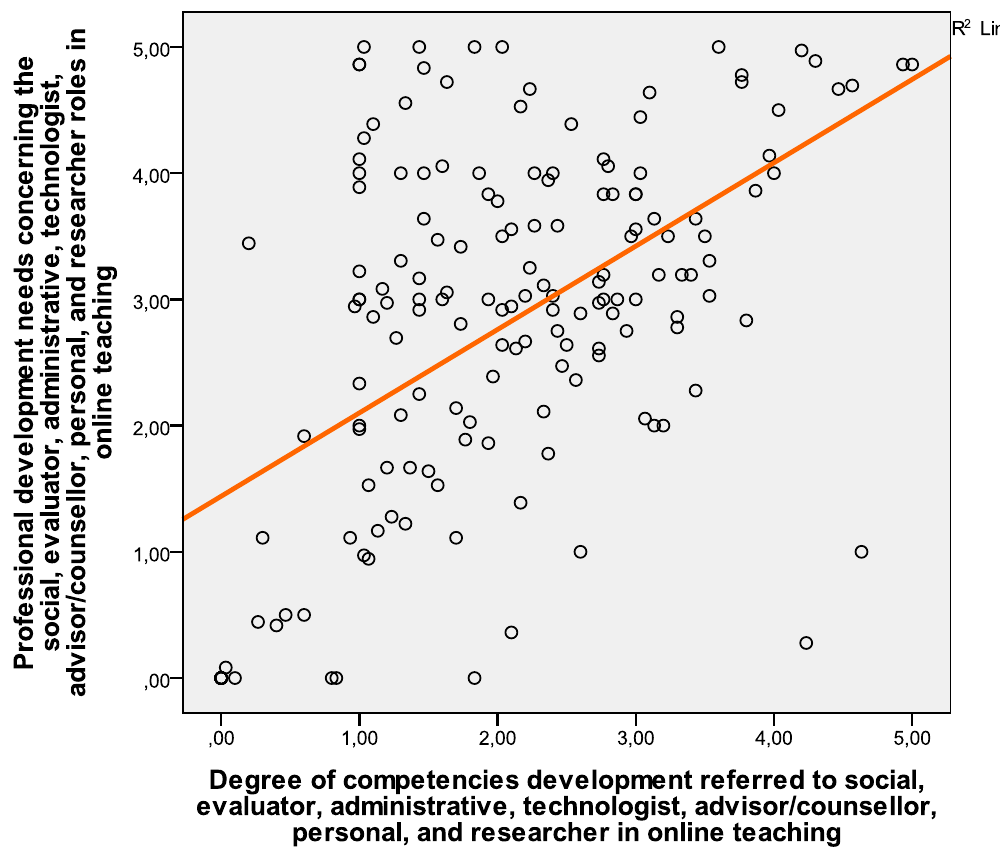
Figure 1 . Scatter plot with regression